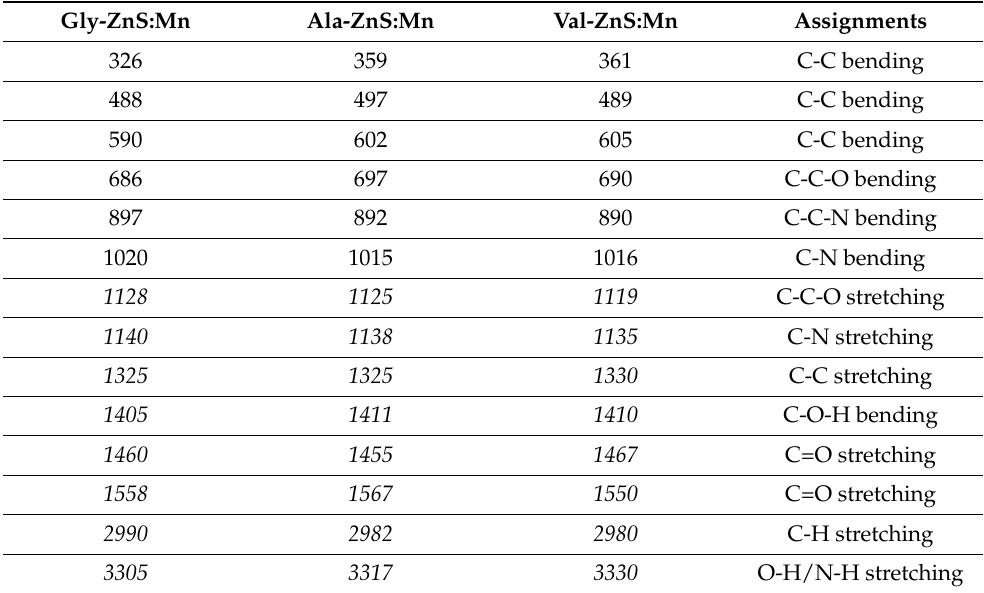
Table 2. FT-IR peak data and their assignment for Gly-ZnS:Mn, Ala-ZnS:Mn, and Val-ZnS:Mn